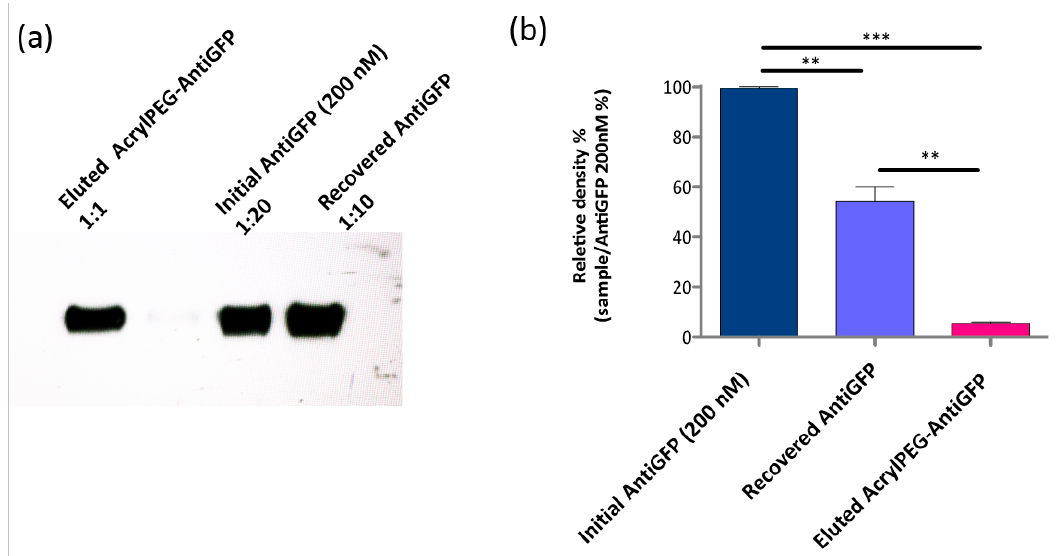
Figure 7. Western blot analysis ( a ) and relative density percentage ( b ) of mother solution of Anti-GFP (blue bar), Anti-GFP recovered after incubation (light blue bar), and PEG-Anti-GFP eluted from the solid substrate (pink bar). Reported values have been averaged over three measurements. Error bars represent standard deviation (SD) (*** p < 0.001, ** p < 0.01).